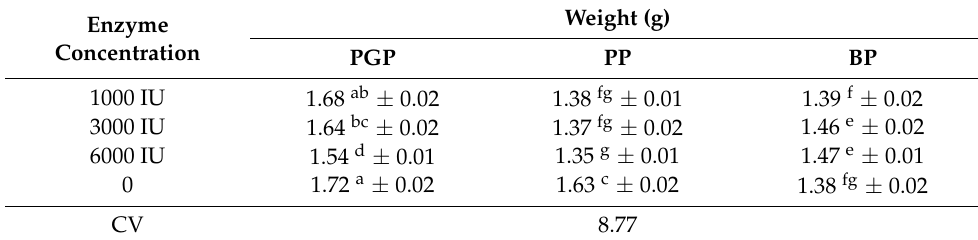
Table 3. Mass of constant dried samples after fermentation.